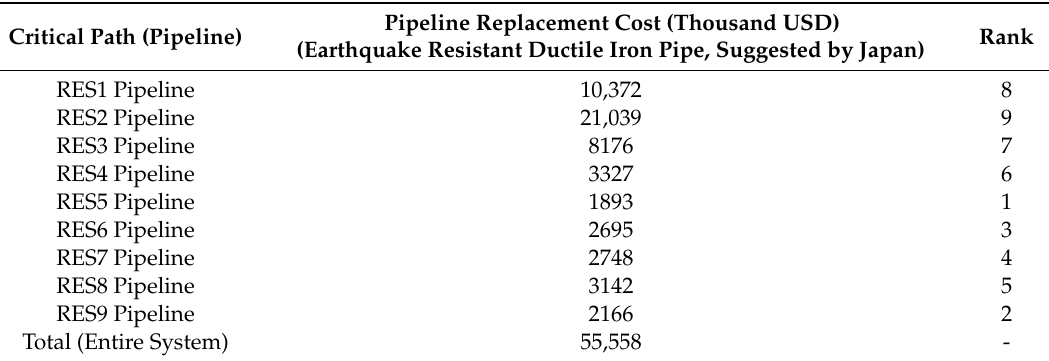
Table 4. Pipeline Replacement Cost by Critical